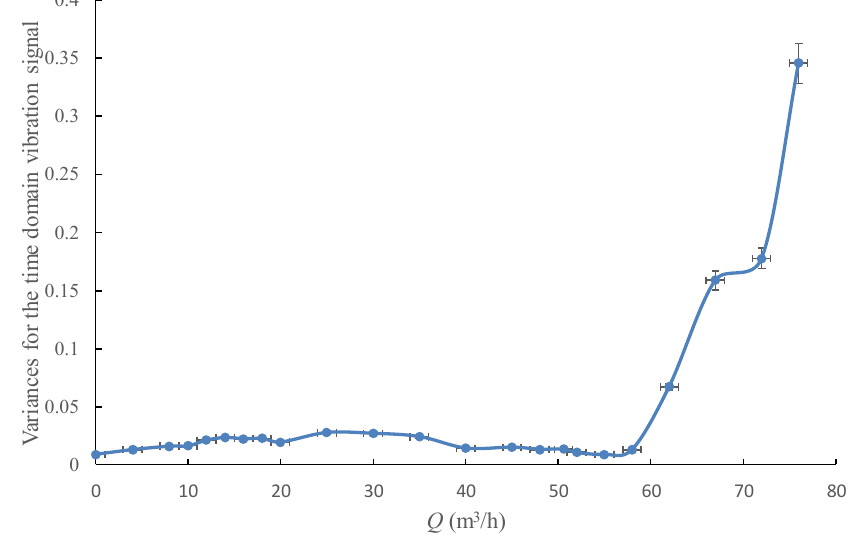
Figure 13. Variances for the time domain vibration signal under different flowrates.